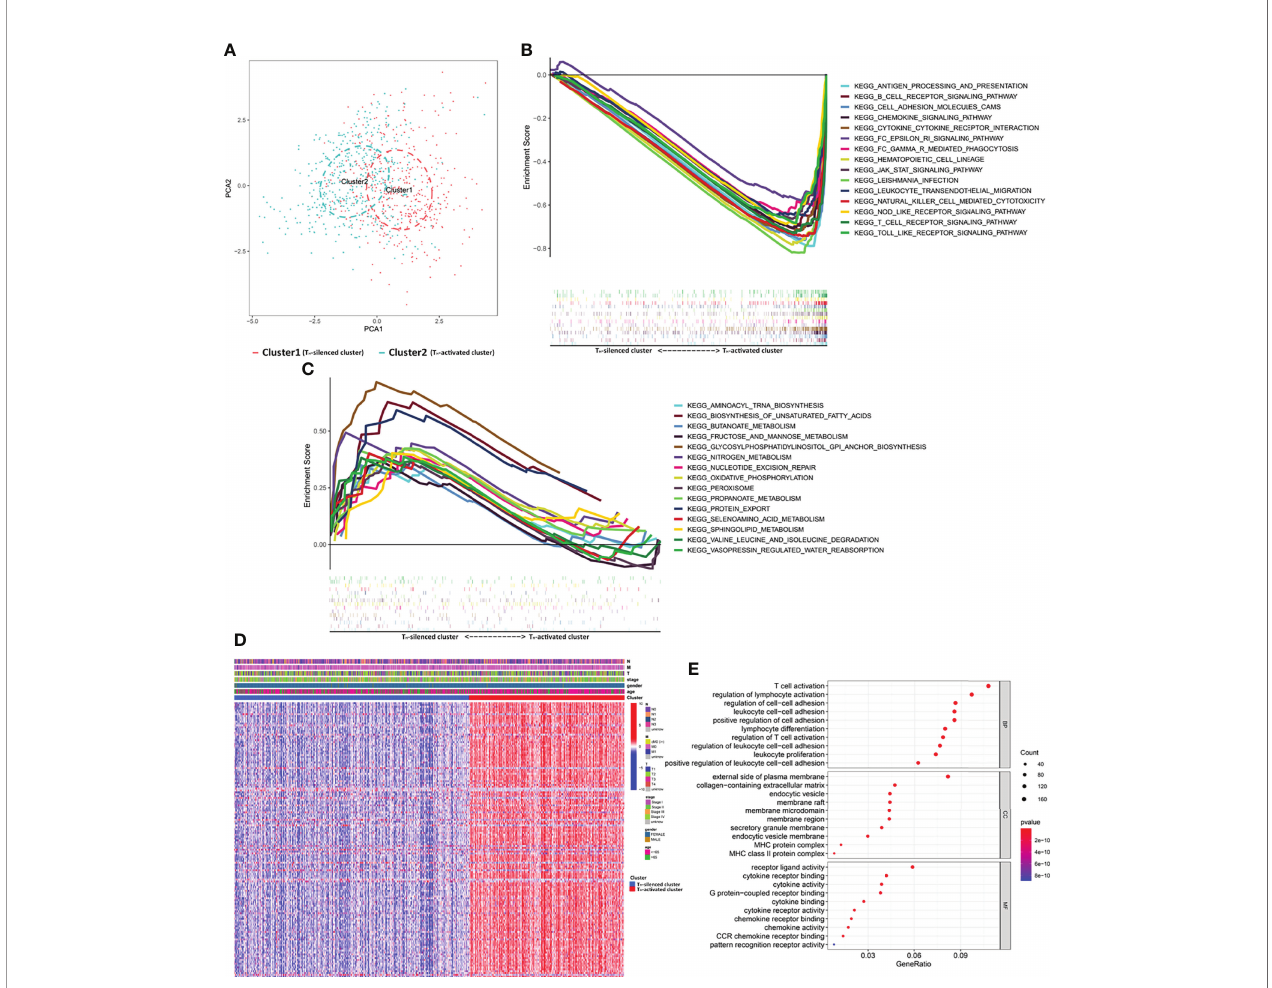
FIGURE 2 | The gene pro fi le characteristics of two clusters identi fi ed by T H cells from TCGA breast cancer samples cued the correlation between T H cells and ECM in the TIME. (A) PCA diagram of 1,090 samples classi fi ed into T H -silenced cluster and T H -activated cluster. (B) GSEA showed that the pathways of NES top 15 in the T H -activated cluster included abundant immune-related KEGG pathways, while (C) top 15 in the T H -silenced cluster included glucose metabolism- and fatty acid synthesis-related pathways. (D) The heatmap of differential expression of the DEGs in the two clusters (logFC fi lter=2 and fdrFilter=0.05) and the distribution of clinical information. (E) GO enrichment analysis of the DEGs showed that collagen-containing ECM was enriched except for the immune-activated